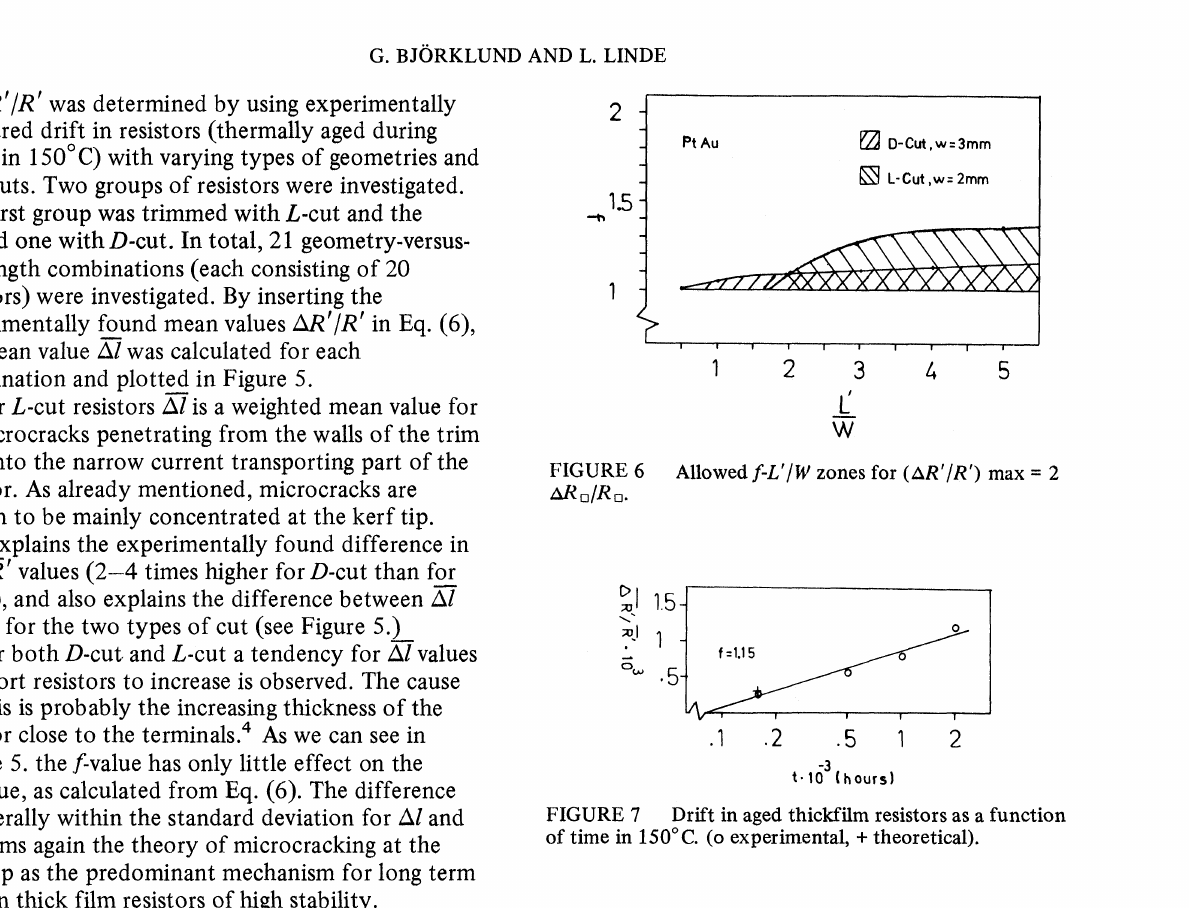
D-cut with low trimming degree should be preferred due to the increase in A1 for short L-cut resistors (see Figure 5).